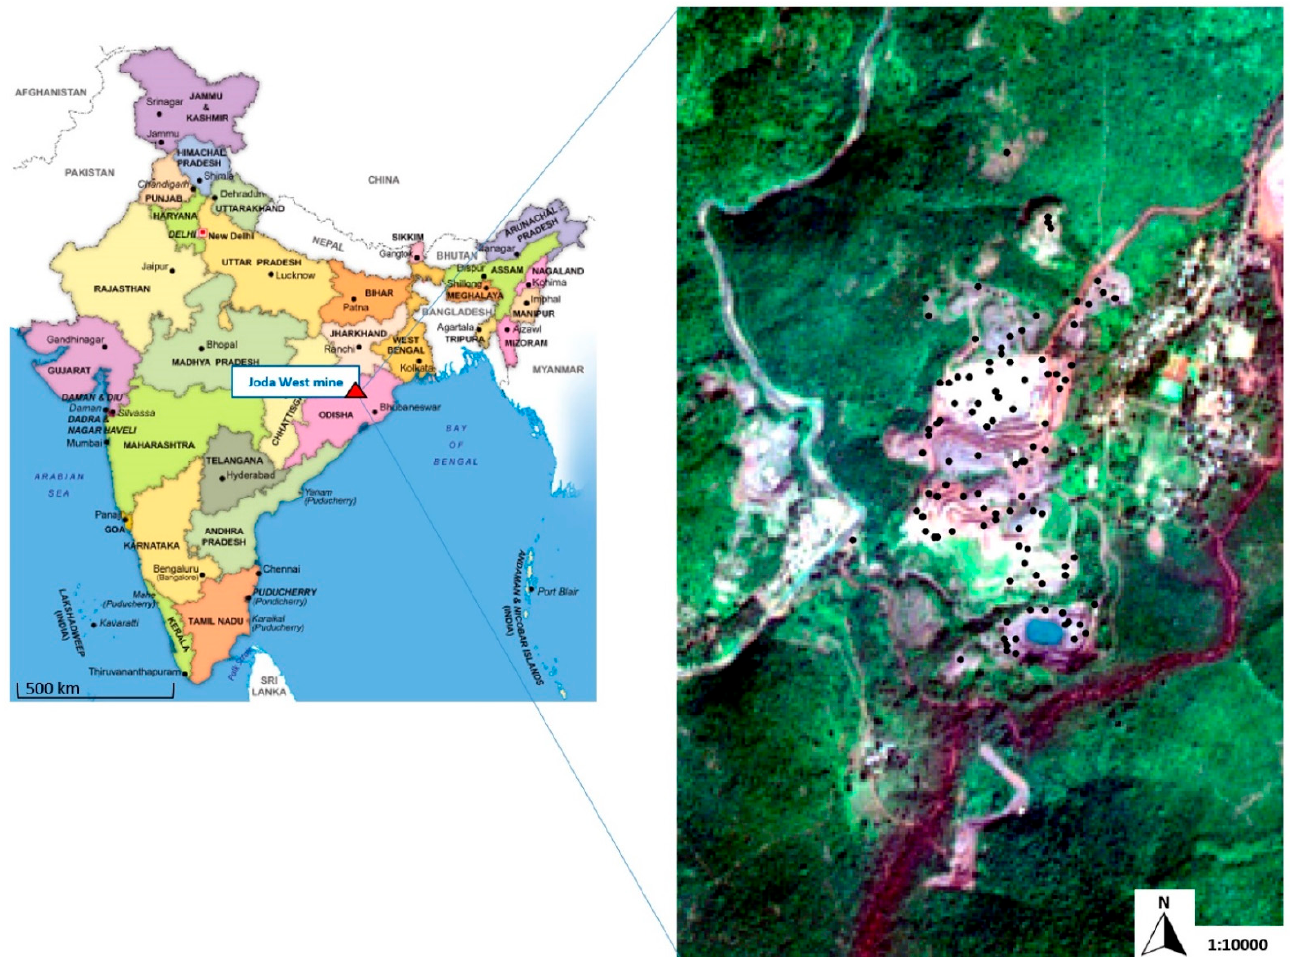
Figure 1. Fe and Mn mine of Joda West study area with 100 samples (black dots) highlighted on the Sentinel-2A image.